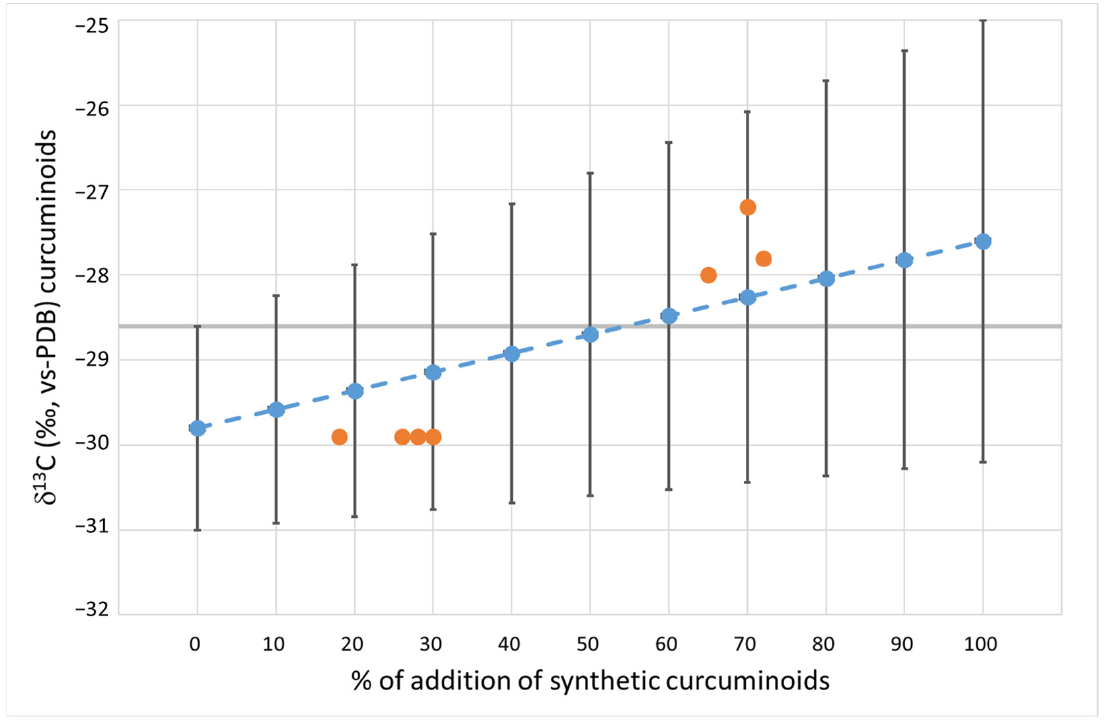
dots: mean value. Bars: 95% confidence limit. Orange dots: measured values of prepared mixtures.